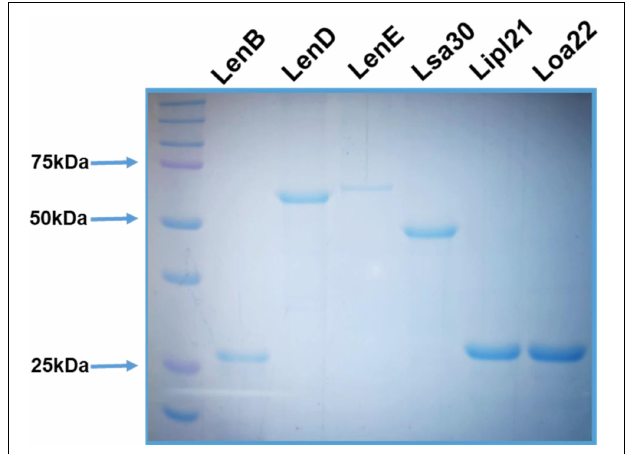
FIGURE 1 | Purification of recombinant surface-exposed lipoproteins: The recombinant proteins were purified as described in section “Materials and Methods”. SDS-PAGE profile shows the pure LenB (27 kDa), LenD (62 kDa), LenE (65 kDa), Lsa30 (45 kDa), Lipl21 (21 kDa), and Loa22 (22